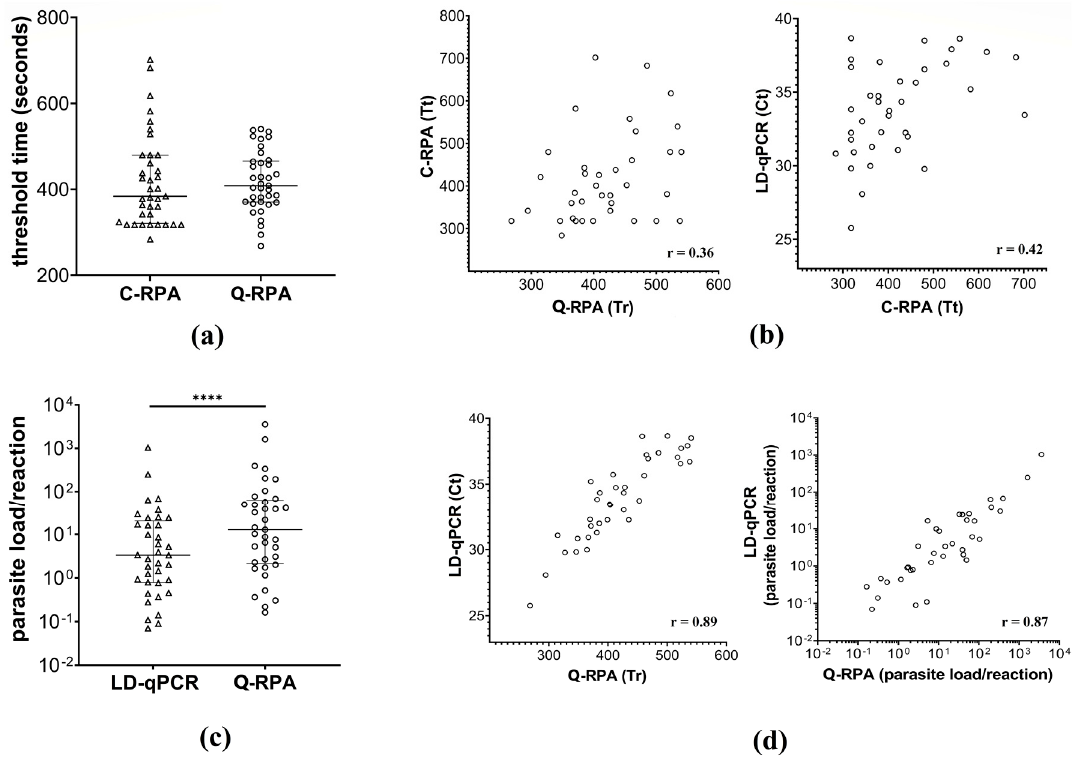
Figure 4. Quantitative performance of Q-RPA assay. ( a ) Threshold time difference between C-RPA (Tt) and Q-RPA (Tr); ( b ) Correlation plots for Tr vs. Tt and Tt vs. Ct; ( c ) Absolute parasite load per reaction extrapolated from LD-qPCR and Q-RPA standard dilution curves, **** p < 0.0001; ( d ) Correlation plot for Tr vs. Ct and relative parasite loads between LD-qPCR and Q-RPA assays.